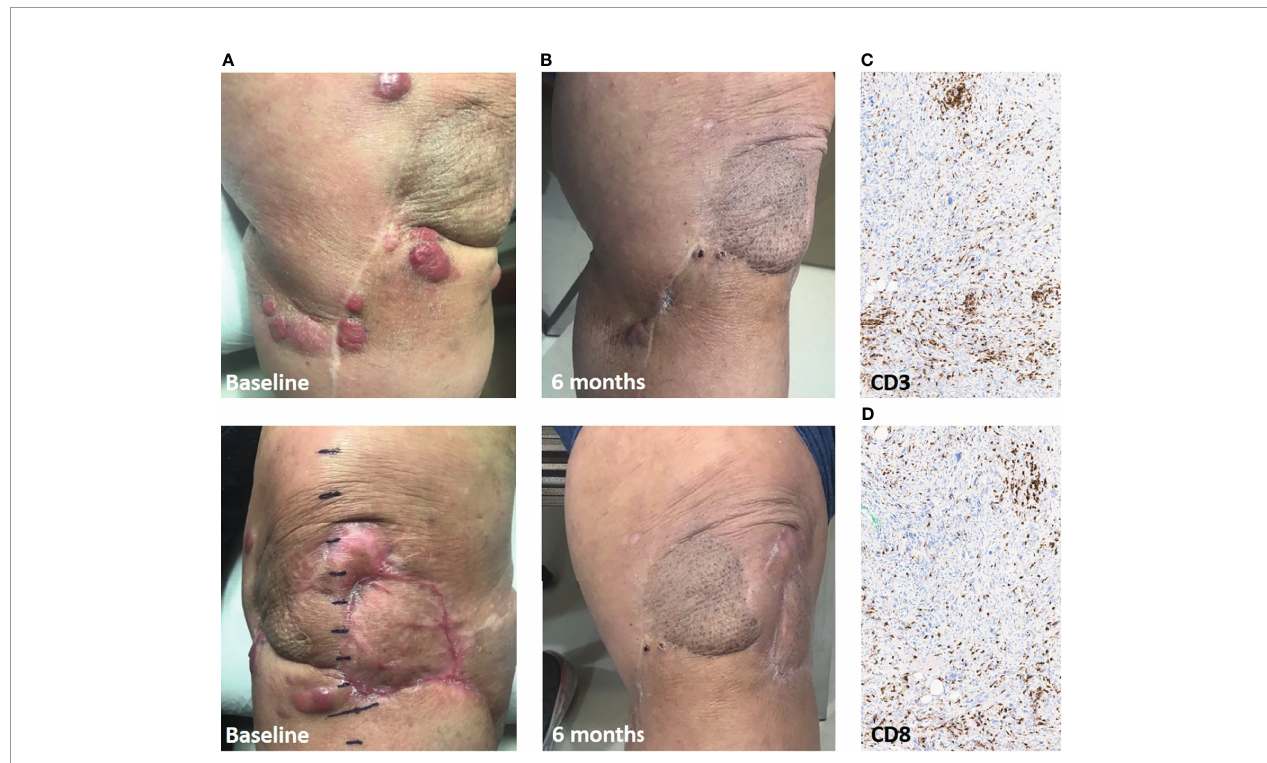
FIGURE 1 | Response in Case 1 treated with ILI and pembrolizumab. (A) , Baseline clinical pictures of the numerous recurrent lesions. (B) , 6-month follow-up demonstrating signi fi cant partial response in the infused limb. (C) , CD3+ T cell in fi ltrate in leg soft-tissue biopsy of a responding lesion. (D) , CD8+ T cell in fi ltrate. Immunohistochemistry images are presented at 20x magni fi